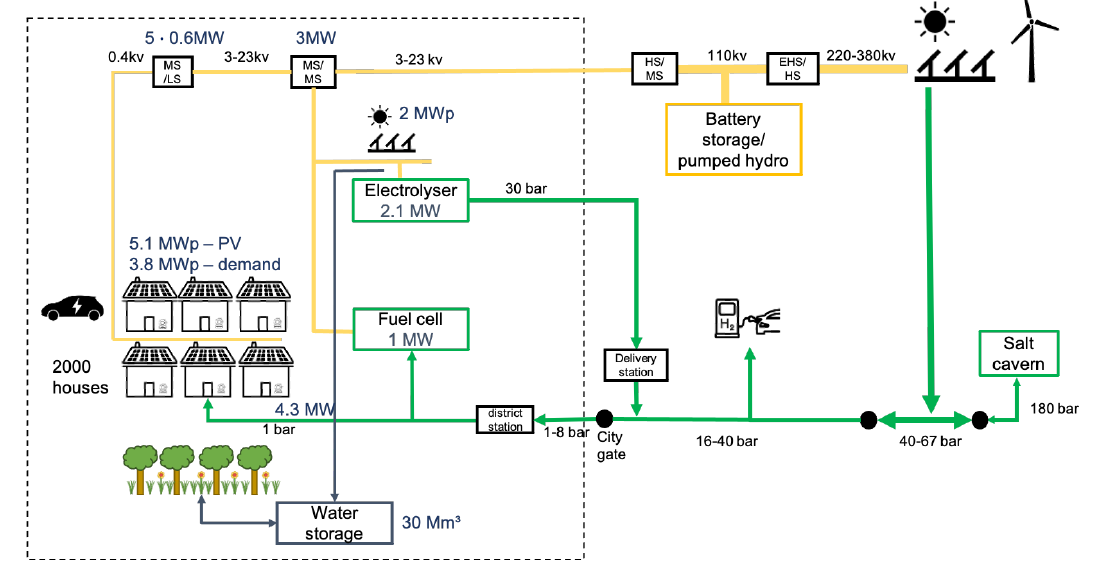
Figure 5. Schematic overview of the H 2 hybrid scenario with power-to-hydrogen and using hydrogen for household heating demand. The electrolyzer (2.1 MW el ) is utilized for peak shaving on the supply side (PV on roofs and the local PV park). The houses are retrofitted to a lesser extend (label C) than in the all-electric scenarios (see Table 4), which results in higher heating demands. In this scenario, we have chosen to fulfill the heating demand with hybrid heat pumps with hydrogen boilers. The hydrogen boilers assist the heat pump at cold periods (< - 5 °C), and for tap water production, so the houses are heated comfortably while demand peaks are reduced. The remainder of the electricity demand peak (3.8 MW el ) is shaved by the 1 MW el fuel cell, preventing grid reinforcement.